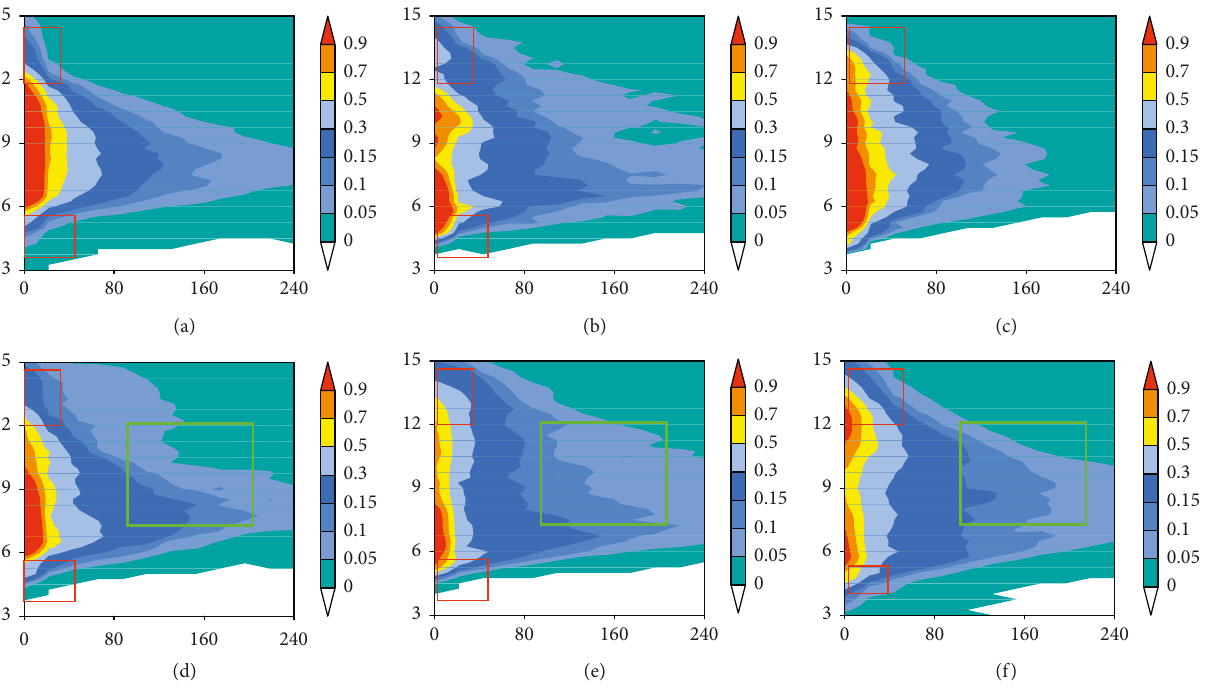
Figure 8: The vertical distribution of the number concentration of ice crystals corresponding to different types of TPV category cloud clusters over each key region: (a) iwc_TP (LR); (b) iwc_ESTP (LR); (c) iwc_MYR (LR); (d) iwc_TP (HR); (e) iwc_ESTP (HR); (f) iwc_MYR (HR) ((a) TP, (b) ESTP, and (c) MYR represent light rain type, and (d) TP, (e) ESTP, and (f) MYR represent heavy rain; X -axis represents particles number concentration (unit: mg/m 3 ); Y -axis represents altitude (unit: km); shaded color represents the percentage of frequency (unit: %); and red and yellow box represents the significant discrepancy area)).